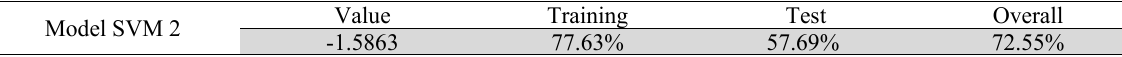
The results of SVM-2 model